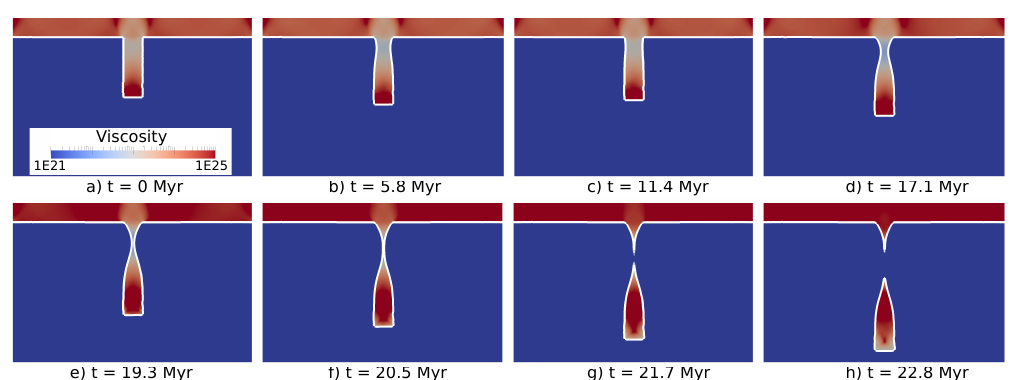
Figure 9. Snapshots of viscosity during the necking process. The white line indicates the zero isocontour of the level set function. Note that the frames are plotted with different time intervals to demonstrate the acceleration of slab